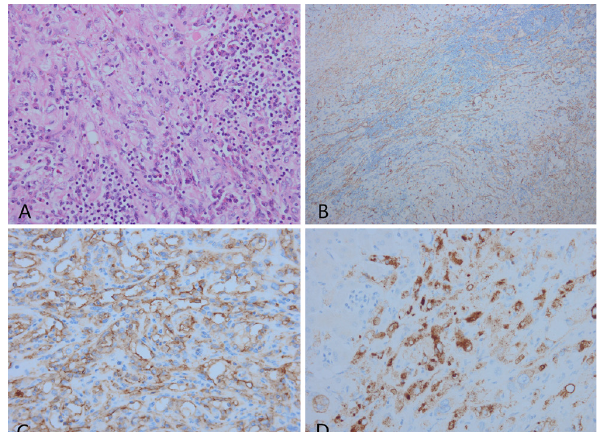
Figure 2: Pathological investigation identified hepatic epithelioid hemangioendothelioma: (A) Tumor cells manifested as epitheli- oid with rich cytoplasm, some of which revealed intracytoplasmic vascular lumen formation containing erythrocytes (HE×400). (B) immunohistochemistry showed that the tumor was positive for CD34 (HE×100); (C) immunohistochemistry showed that the tumor